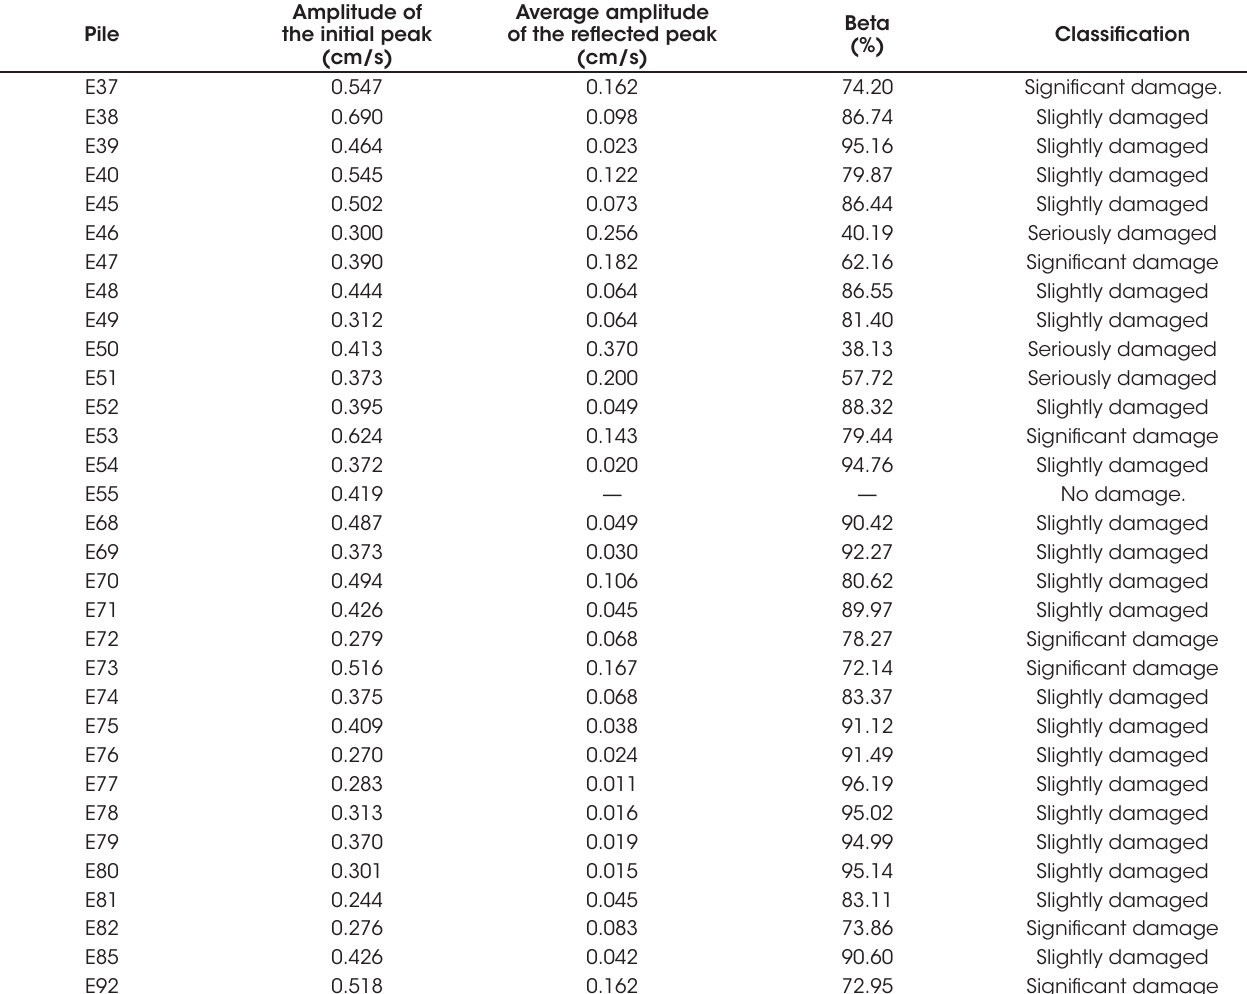
Summary of Beta values (%) obtained in the piles of Group